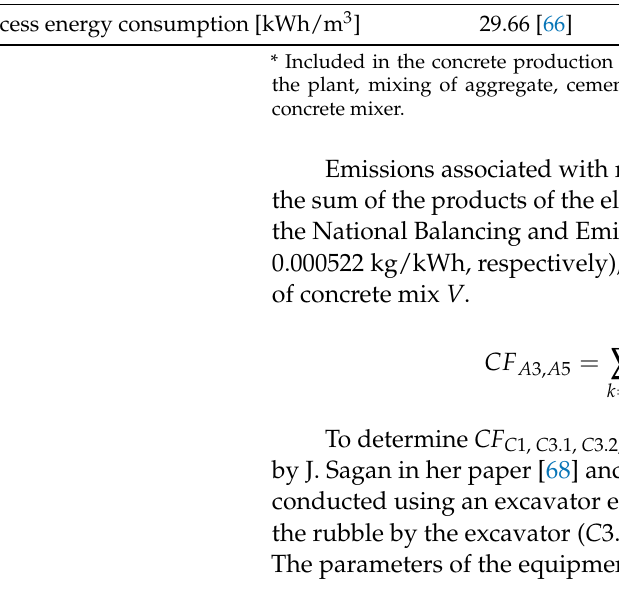
Table 6. Equipment parameters. Own elaboration based on